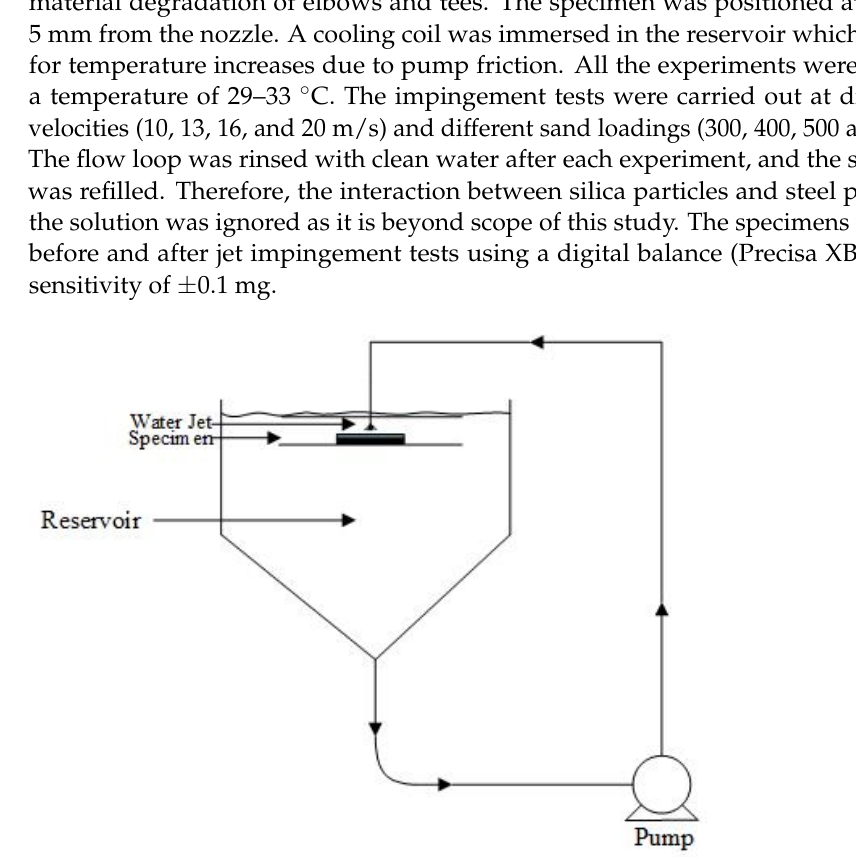
Figure 3. Experimental setup (SIJ) used in this study .